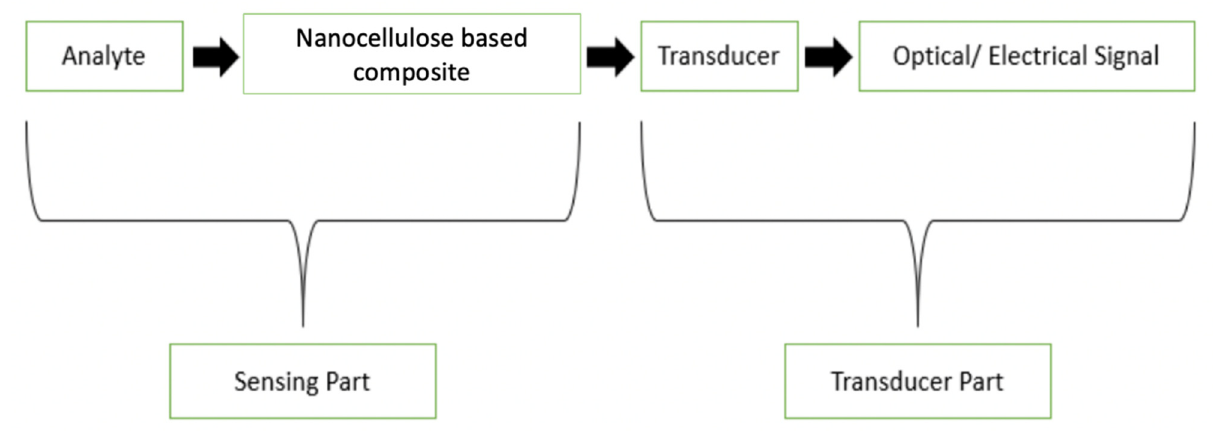
Figure 6. Structure of nanocellulose composites chemical sensors.